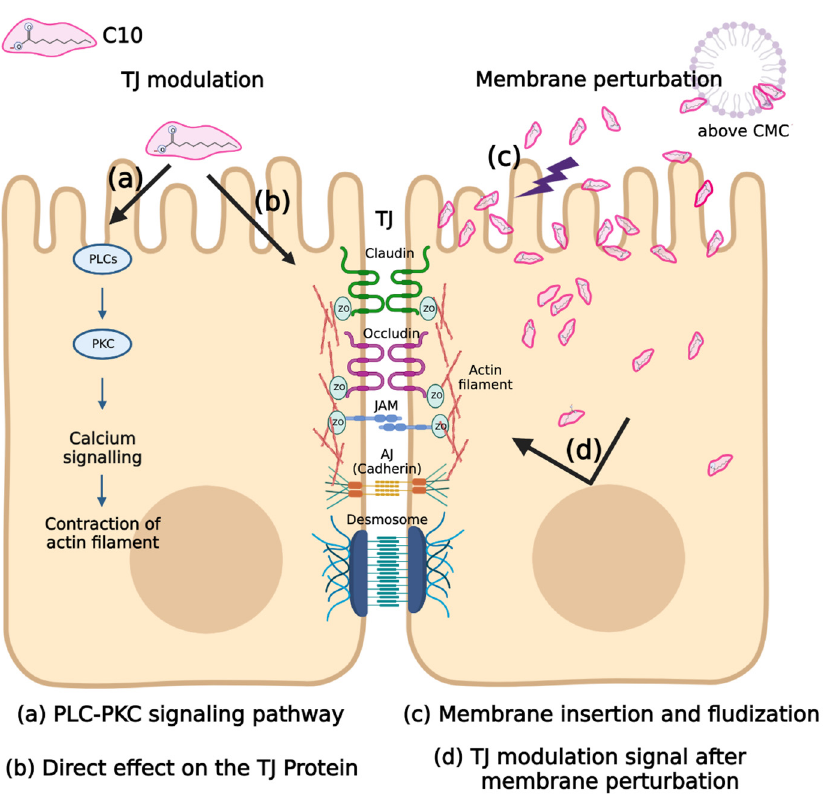
Figure 3. Hypotheses on the mechanism of C10. The diagram shows the simple classification of the mechanisms of C10 proposed to date. It is essentially divided into tight junction (TJ) modulation (left) and membrane perturbation mechanisms [68]. The TJ modulation hypothesis is divided into a Ca 2+ -dependent PLC-PKC pathway mechanism ( a ) and a Ca2+-independent TJ protein modulation ( b ). As per the membrane perturbation hypothesis, the mechanism of action of C10 can be its insertion into the membrane to fluidize the membrane and enhance absorption into the transcellular pathway ( c ), and an unknown TJ modulation signal due to membrane perturbation ( d ).